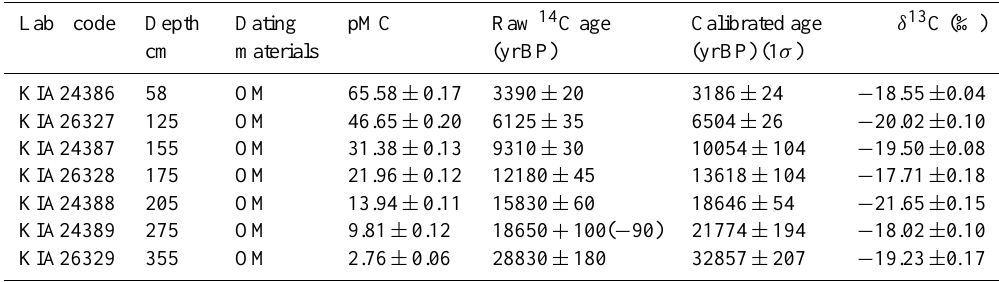
Table 1. Accelerator mass spectrometry (AMS) 14 C dates of sediment core SK177/11. Radiocarbon ages were calibrated using the CALIB 6.0 program (http://calib.qub.ac.uk/calib/calib.html, Reimer et al.,